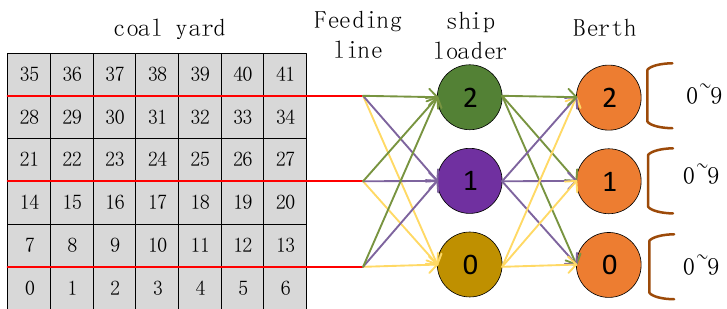
the total number of actions is 42 × 3 × 3 × 10 = 3780.